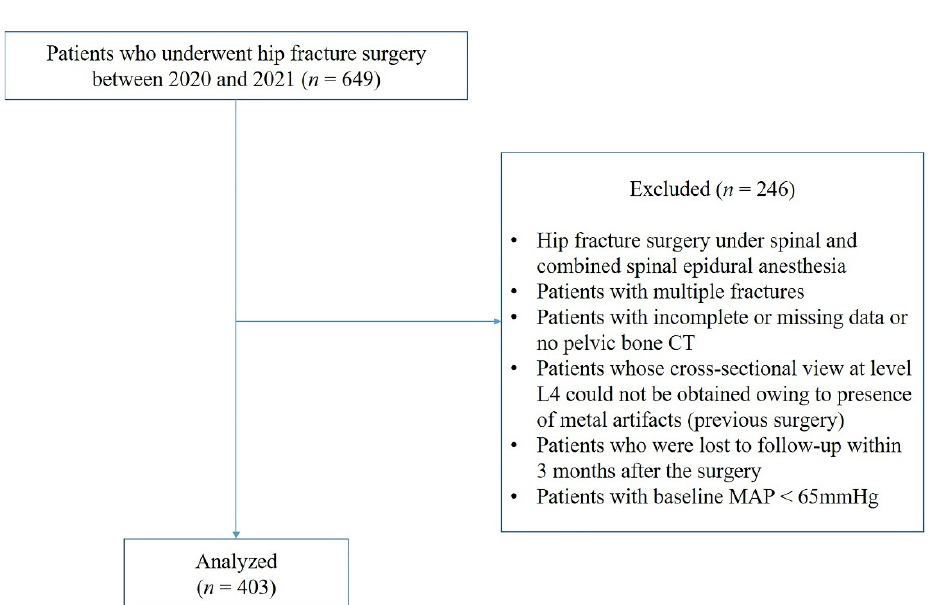
Figure 1. Study flow